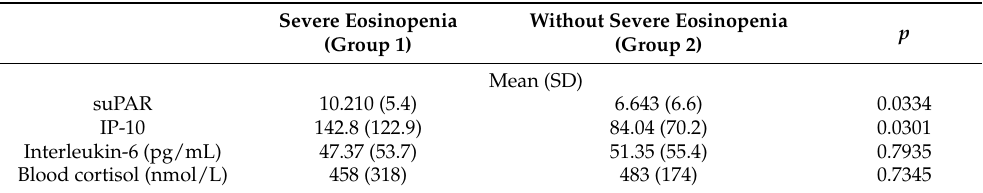
Table 2. suPAR, IP-10, IL-6, and cortisol levels in hospitalized COVID-19 patients with and without severe eosinopenia.